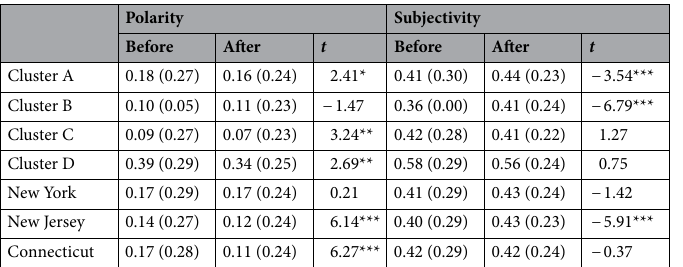
Table 4. Descriptive statistics and t-test results on polarity and subjectivity. * p < 0.05, ** p < 0.01, *** p <